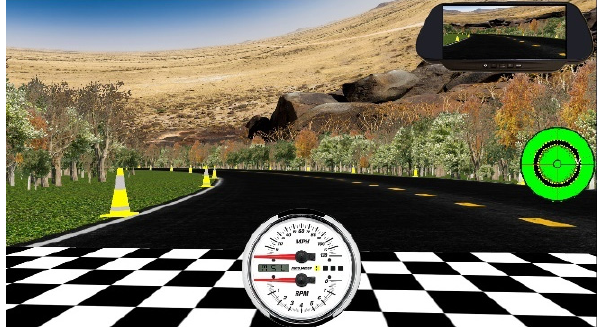
Figure 5. The skid pad scenario (CC).